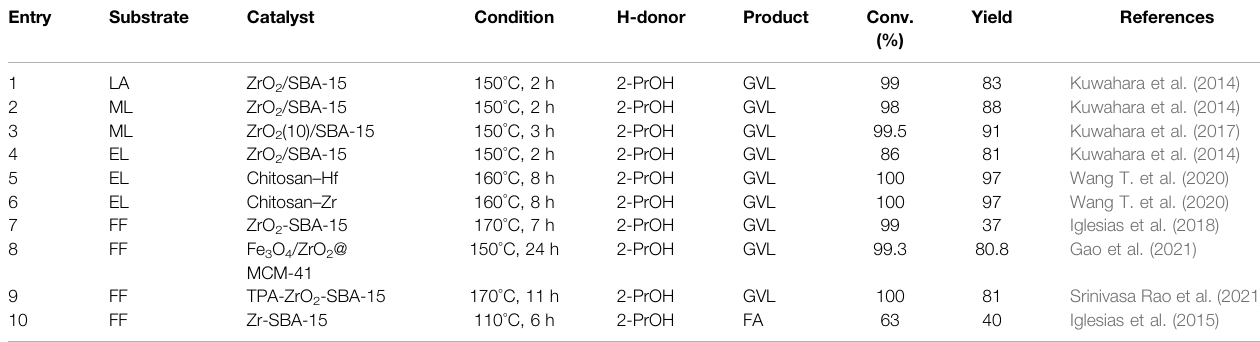
TABLE 2 | Zr/Hf-containing supported material